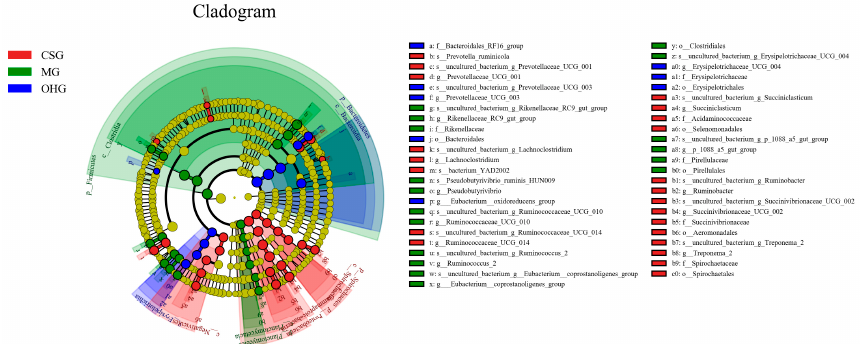
Figure 7. Bacterial taxa significantly di ff erentiated between samples padded di ff erent groups identified by linear discriminant analysis e ff ect size